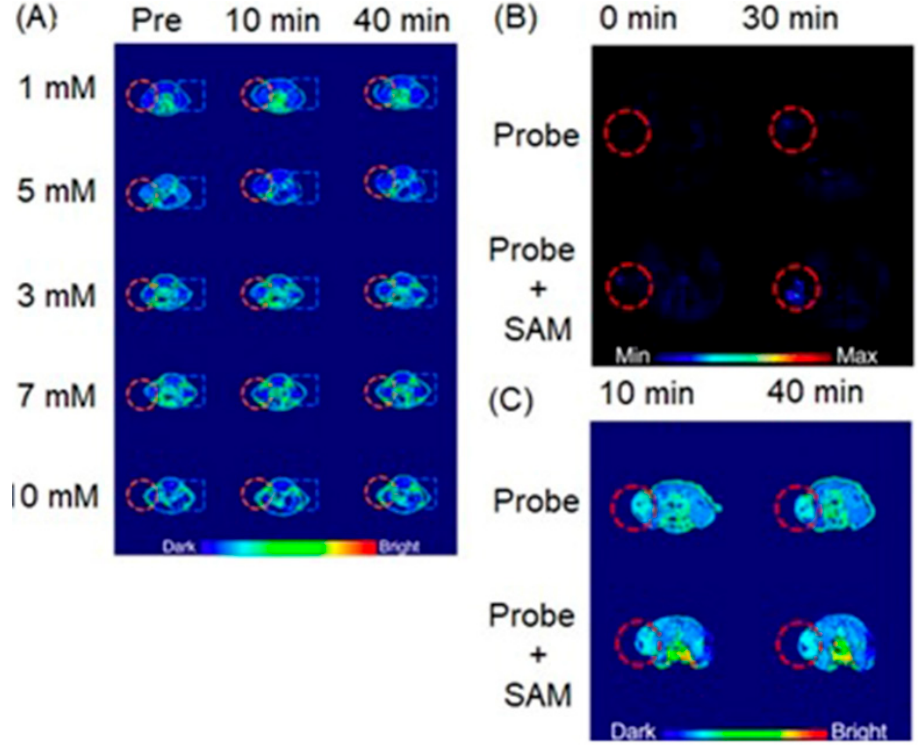
Figure 56. ( A ) T 1 -weighted MRI images of nude mice administered with probe and different amounts of NaHS (1, 3, 5, 7, and 10 mM; left side of the mouse) or phosphate-buffered saline (control; right side of the mouse) acquired before and at 10 and 40 min after injection. Orange dashed circles indicate the H 2 S-enhanced regions. Control regions are indicated by blue dashed rectangles. ( B ) In vivo photoacoustic images of HCT-116 tumor-bearing mice acquired at 0 and 30 min after administration of the nanoprobe. ( C ) In vivo T 1 -weighted images of HCT-116 tumor-bearing mice acquired at 0 and 30 min after administration of the nanoprobe. S -adenosyl methionine (SAM) was used to facilitate the enhancement of photoacoustic signal. Adapted with permission from Yan, C.; Liu, D.; An, L.; Wang, Y.; Tian, Q.; Lin, J.; Yang, S. Magnetic–photoacoustic dual-mode probe for the visualization of H 2 S in colorectal cancer. Anal. Chem. , 2020 , 92 , 8254–8261. Copyright 2020 American Chemical Society [372].